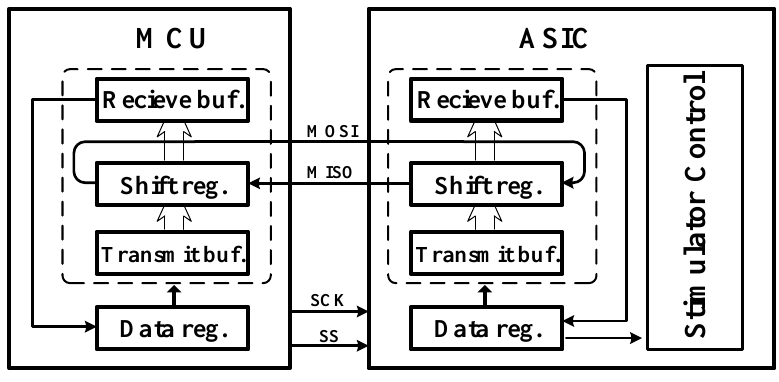
Figure 8. Block diagram of the SPI communication interface. The Master Output Slave Input (MOSI) and Master Input Slave Output (MISO) pins are used to receive and transmit data between the proposed ASIC and the off-chip devices. SCK, Serial Synchronous Clock. SS: slave select, buf.: buffer, reg.: regesiter.